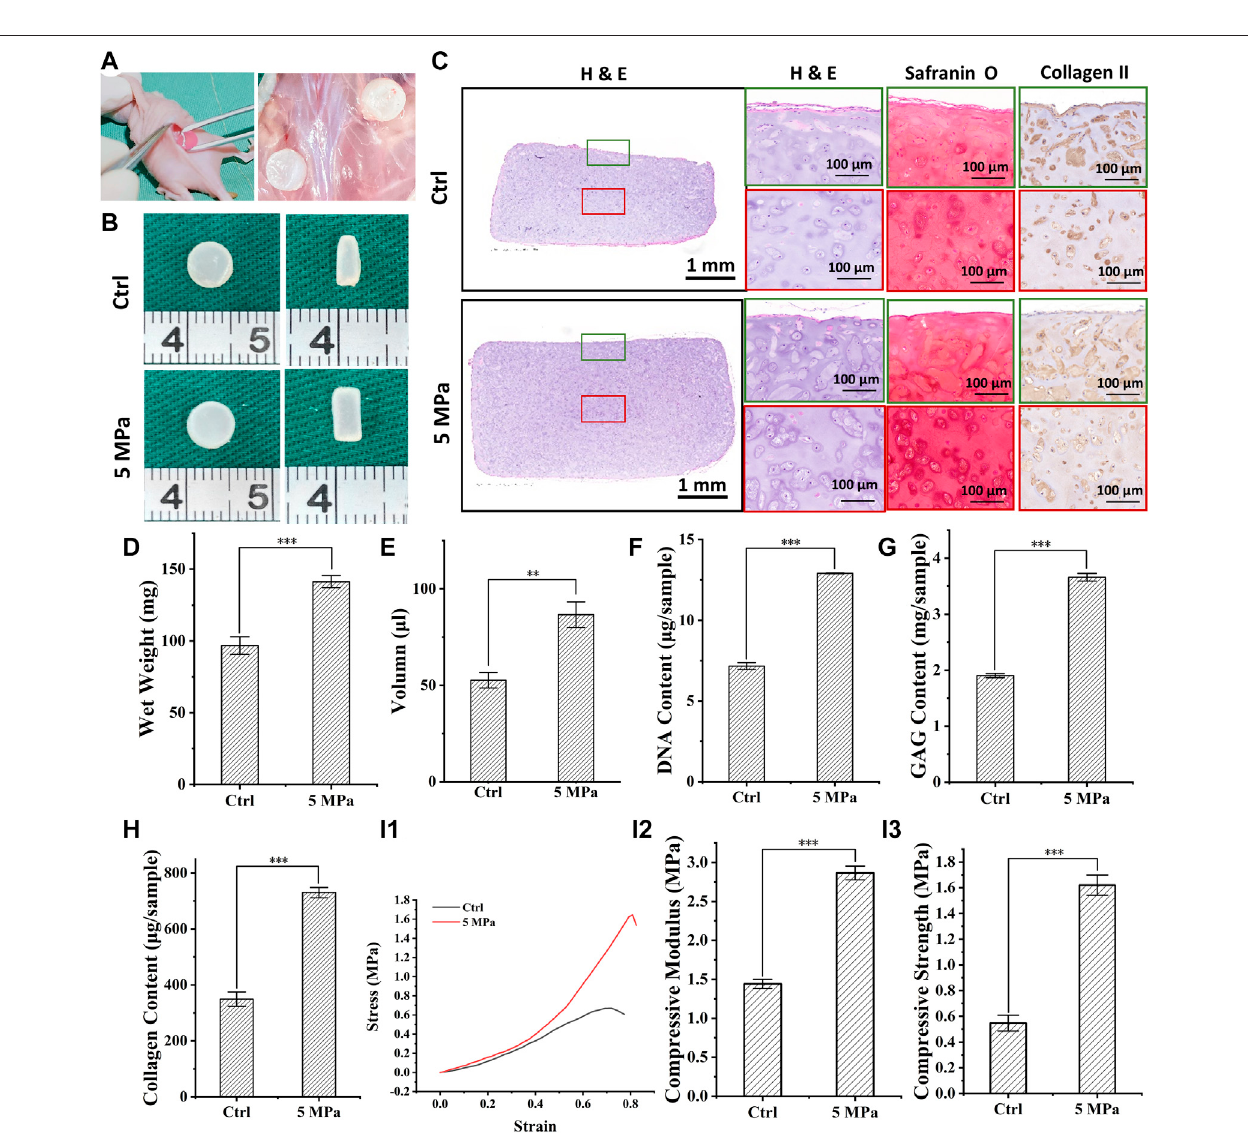
FIGURE7| Invivo evaluationof invitro regeneratedcartilagebasedonHPChydrogels. (A) Theprocessofsurgeryandsamplecollection. (B) Frontandlongitudinal section view of implanted regenerated cartilage after 4 weeks (C) H & E, Safranin O and type II collagen staining of implanted regenerated cartilage after 4 weeks (D – H) Wet weight (p < 0.001) (D) , volume (p < 0.01) (E) , DNA content (p < 0.001) (F) , GAG content (p < 0.001) (G) , and total collagen content (p < 0.001) (H) of implanted regenerated cartilage after 4 weeks (I) Stress-strain curve (I1) , compressive modulus (I2) , and compressive strength (I3) (p < 0.001) of implanted regenerated cartilage after 4 weeks. Green frames indicate the peripheral regions and red frames indicate the central